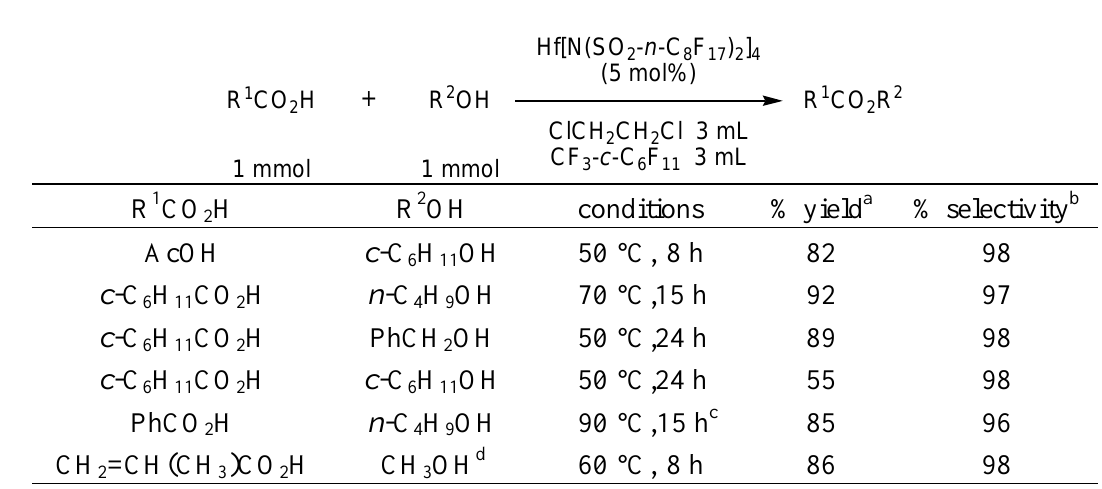
Table 3. Direct esterification of carboxylic acid and